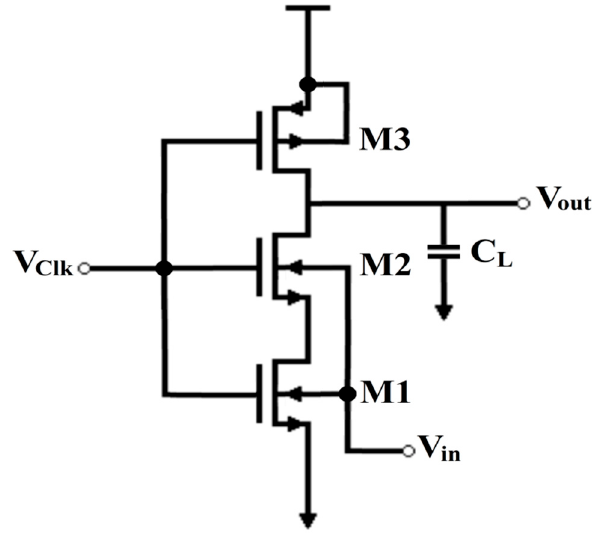
Figure 2. First proposed voltage-to-time converter (VTC) circuit.